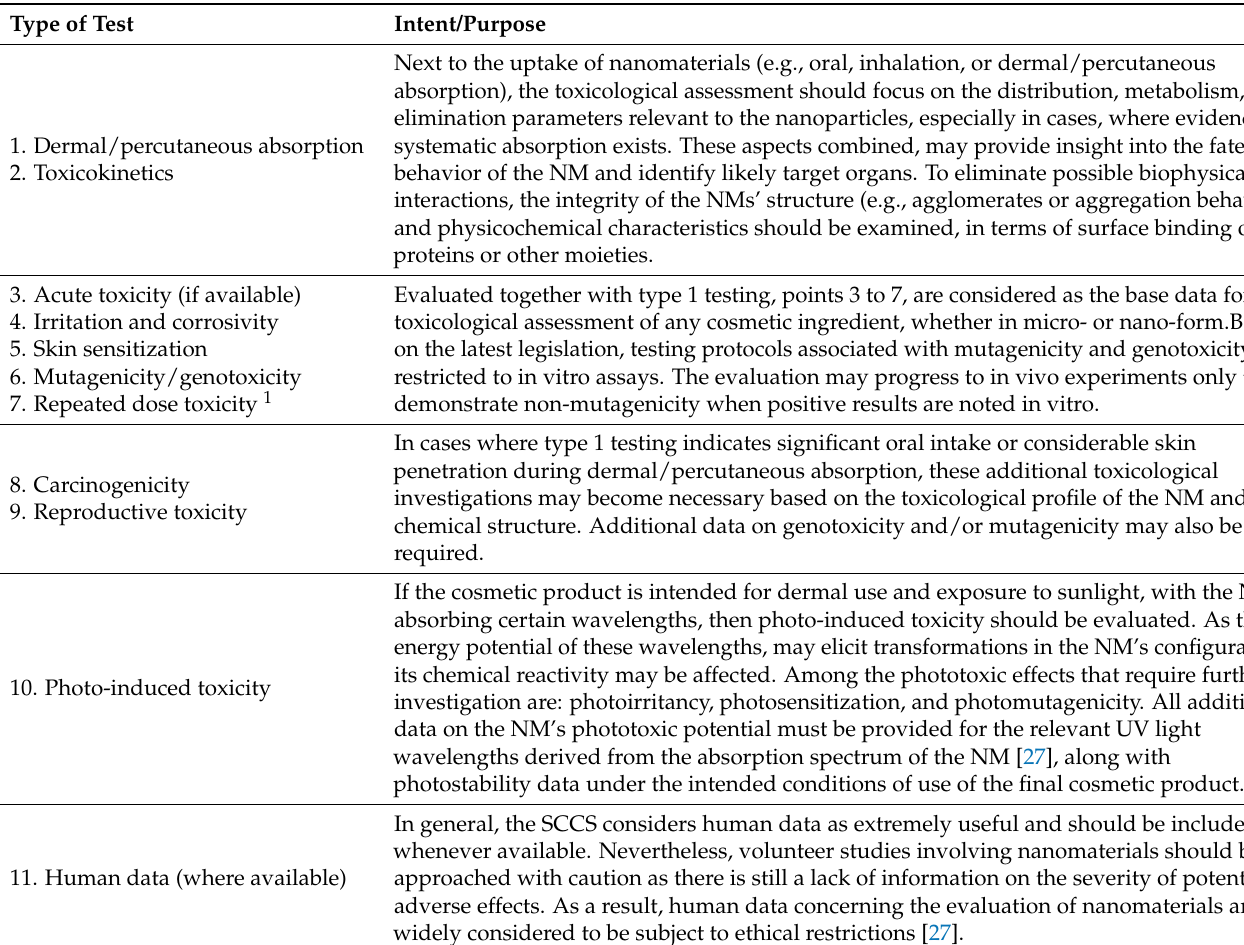
Table 3. Checklist of toxicological data